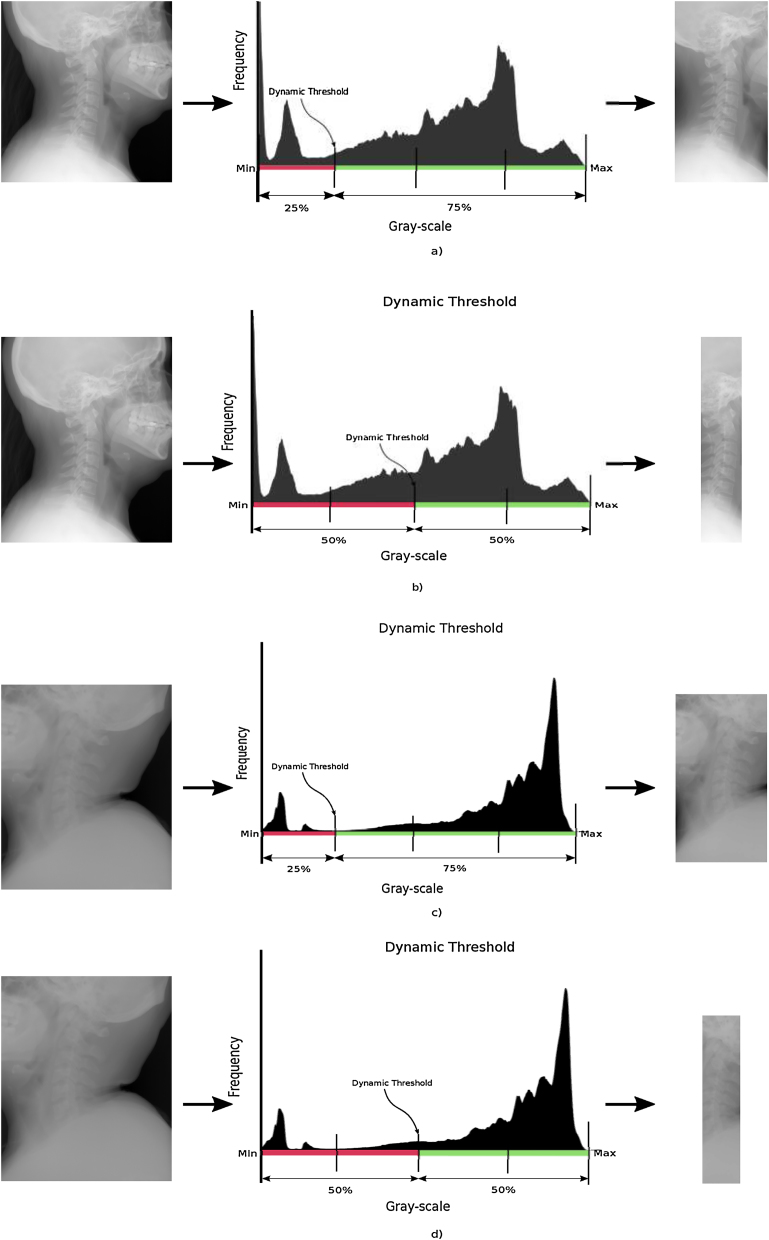
Dynamic threshold.